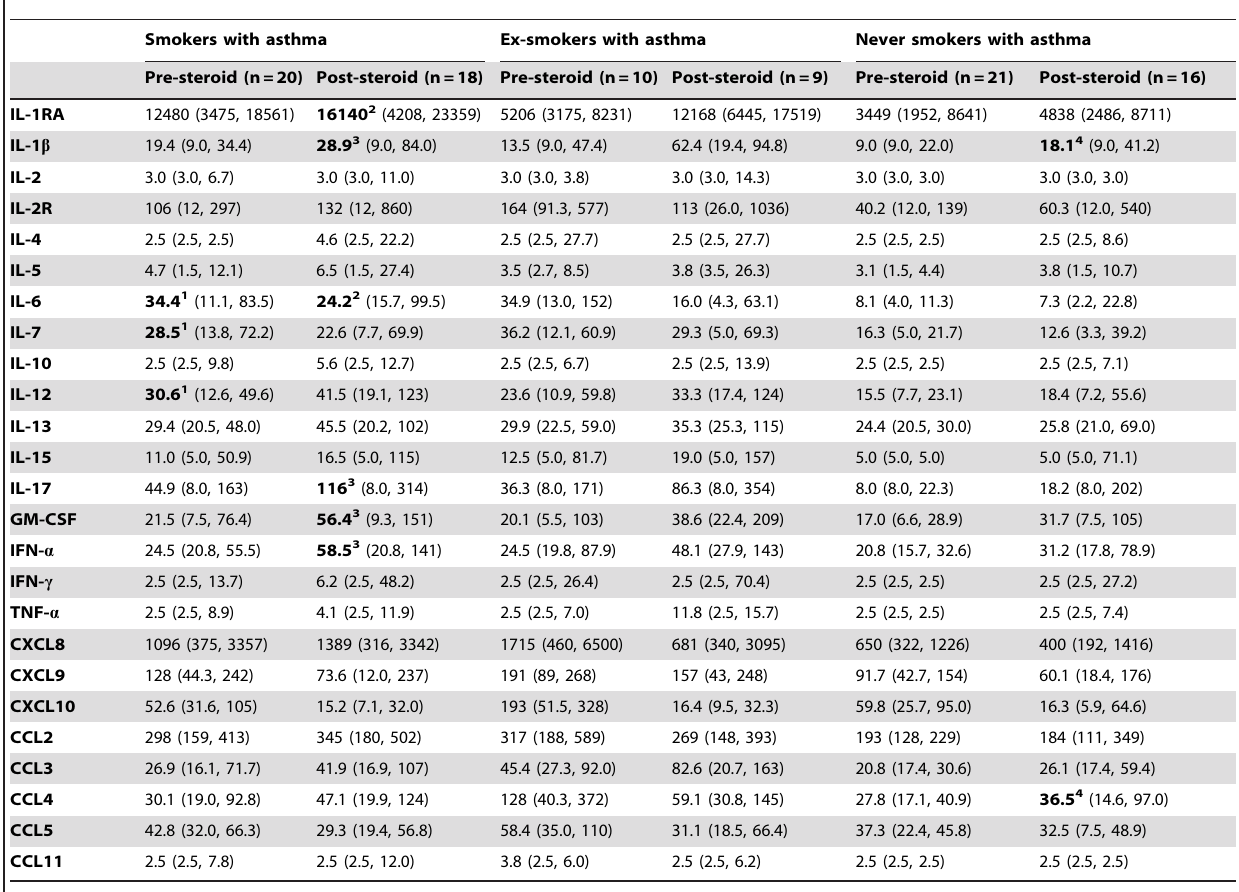
Table 3. Sputum supernatant cytokine concentrations before and after two weeks of oral dexamethasone.